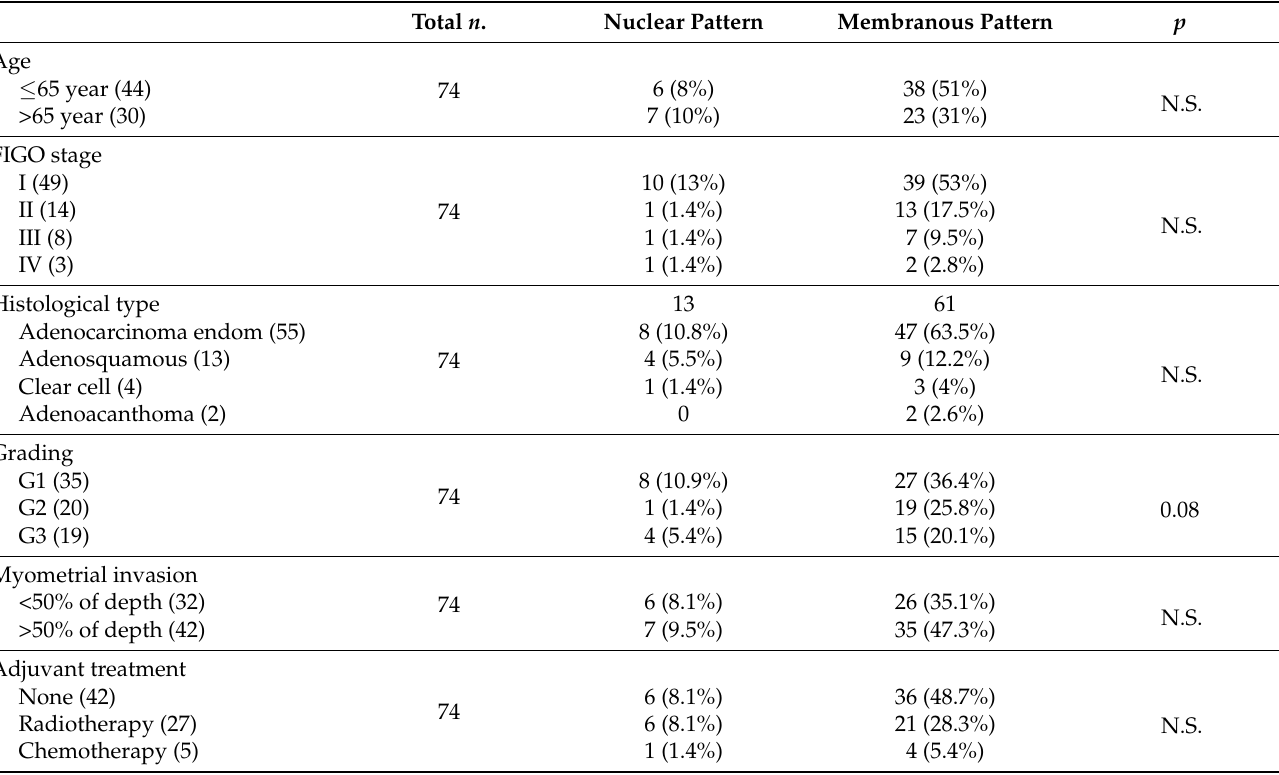
Table 1. Relationship between β -Catenin Expression and Clinicopathological Features in Endometrial Carcinomas.